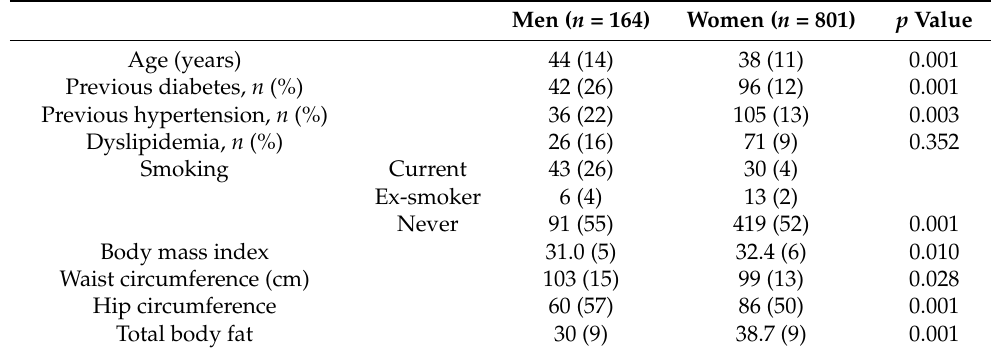
Table 2 shows baseline characteristics, demographic, anthropometric, blood pressure and biochemical data of all subjects divided by sex. BMI, hip circumference, total body fat, HDL and inflammatory markers (us CRP, TNF) are significantly higher in female subjects, whilst fat free-mass, WC, blood pressure and HbA1c are higher in male subjects ( p < 0.05). Table 2. Baseline clinical, anthropometric, blood pressure and biochemical data of all subjects stratified by sex, mean (SD), unless stated